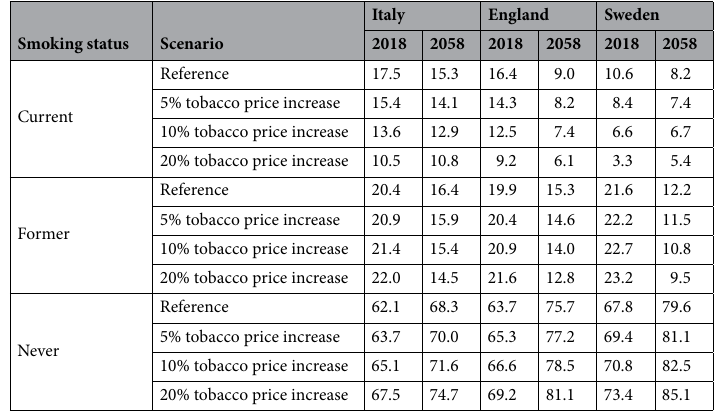
Table 1. Prevalence of current, former and never smoking (expressed in %) at baseline (2018) and at the end of the 40-year simulation (2058). Results reported per country and